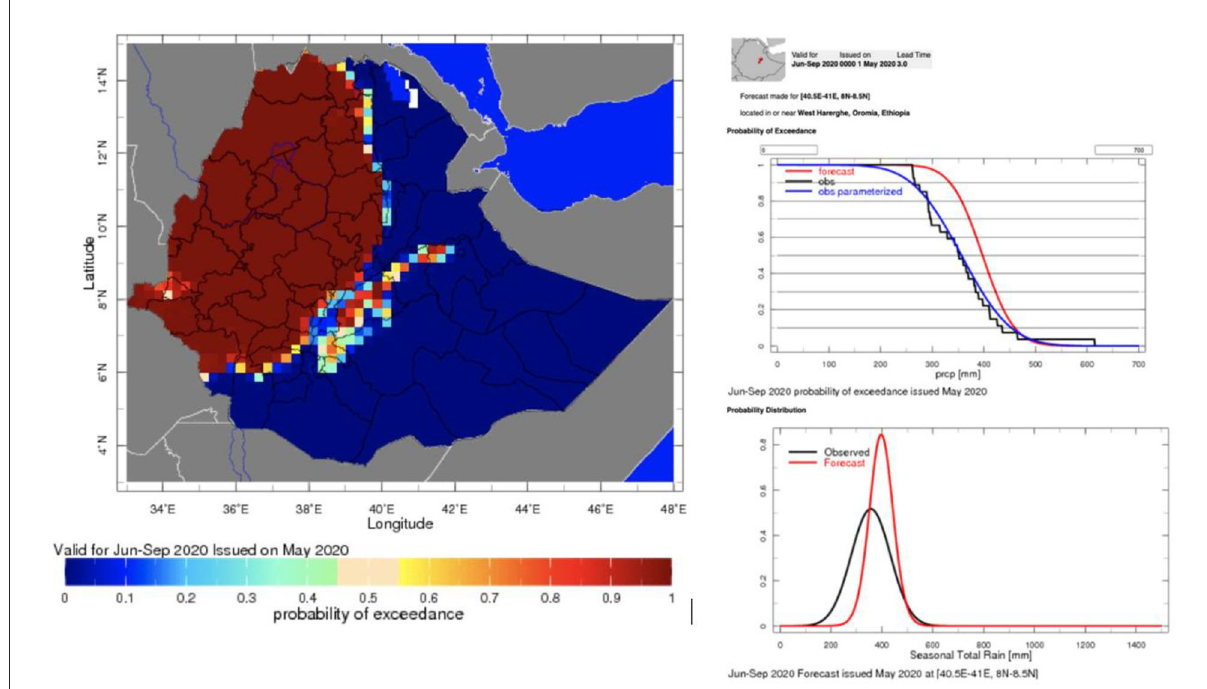
FIGURE4 The NextGen flexible seasonal forecast format for Ethiopia. Both the map and graphs above, screenshots from the EMI’s NextGen maproom (Ethiopian Meteorological Institute, 2022e), show in different formats the probability of seasonal rainfall exceeding 600mm for the Kiremt (June–September) 2020 rainy season for any point in the country, as forecasted in May 2020. With the choice to communicate the seasonal forecast in this flexible format, any user can define any threshold (600mm in this example) of interest to examine probability of exceedance of rainfall, rather than having those values predetermined in terciles, making the forecast more sector-relevant for agricultural